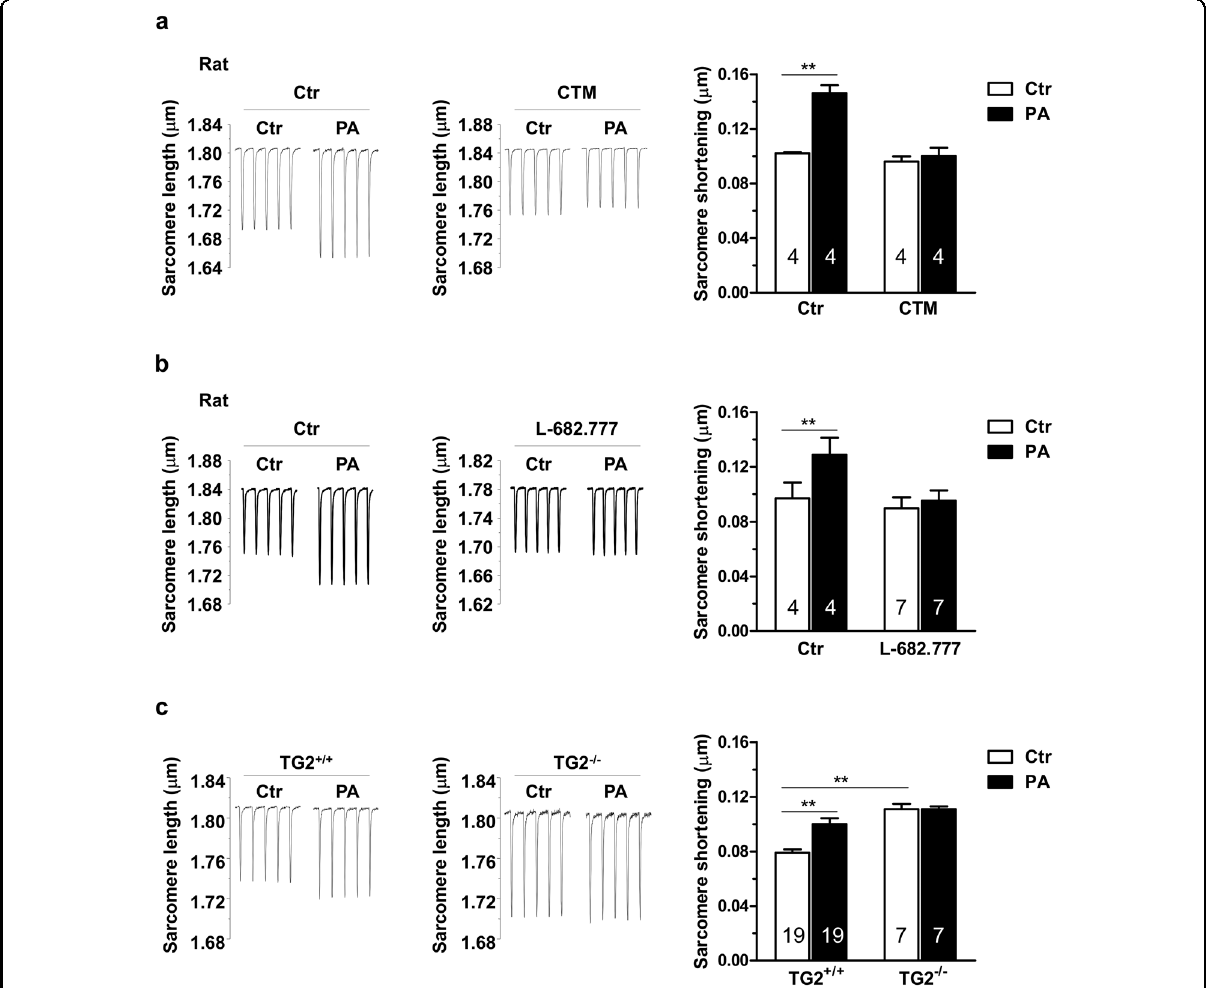
Fig. 2 TG2 mediates palmitic acid-dependent increase of cardiomyocyte contractility. a Sarcomere length of LV myocytes from rats treated with PA was monitored with a video-sarcomere detection system in the absence or presence of CTM (0.5 mM), an inhibitor of TG2 (left). The difference between diastolic and systolic sarcomere length ( Δ sarcomere shortening) was compared (right). b Effect of PA supplementation on sarcomere length in LV myocytes in the absence or presence of L-682.777 (100 μ M), an inhibitor of TG2. c Effect of PA supplementation on sarcomere length in LV myocytes from wild-type and TG2-de fi cient mice. A representative graph is shown. Data represent mean ± S.D. ** P < 0.01 compared